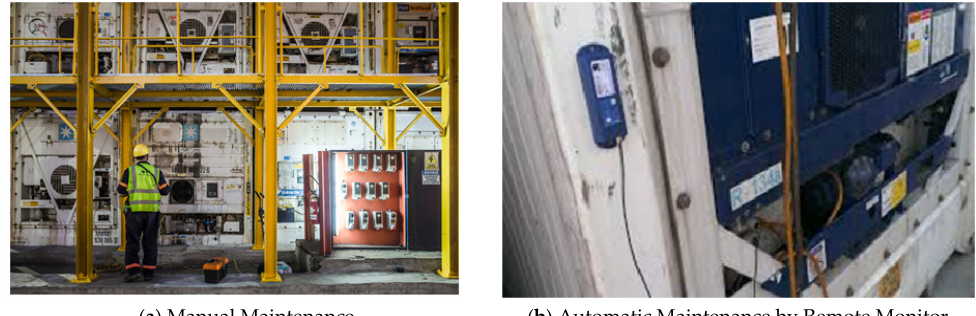
Figure 1. Daily Reefer Container Park Maintenance.